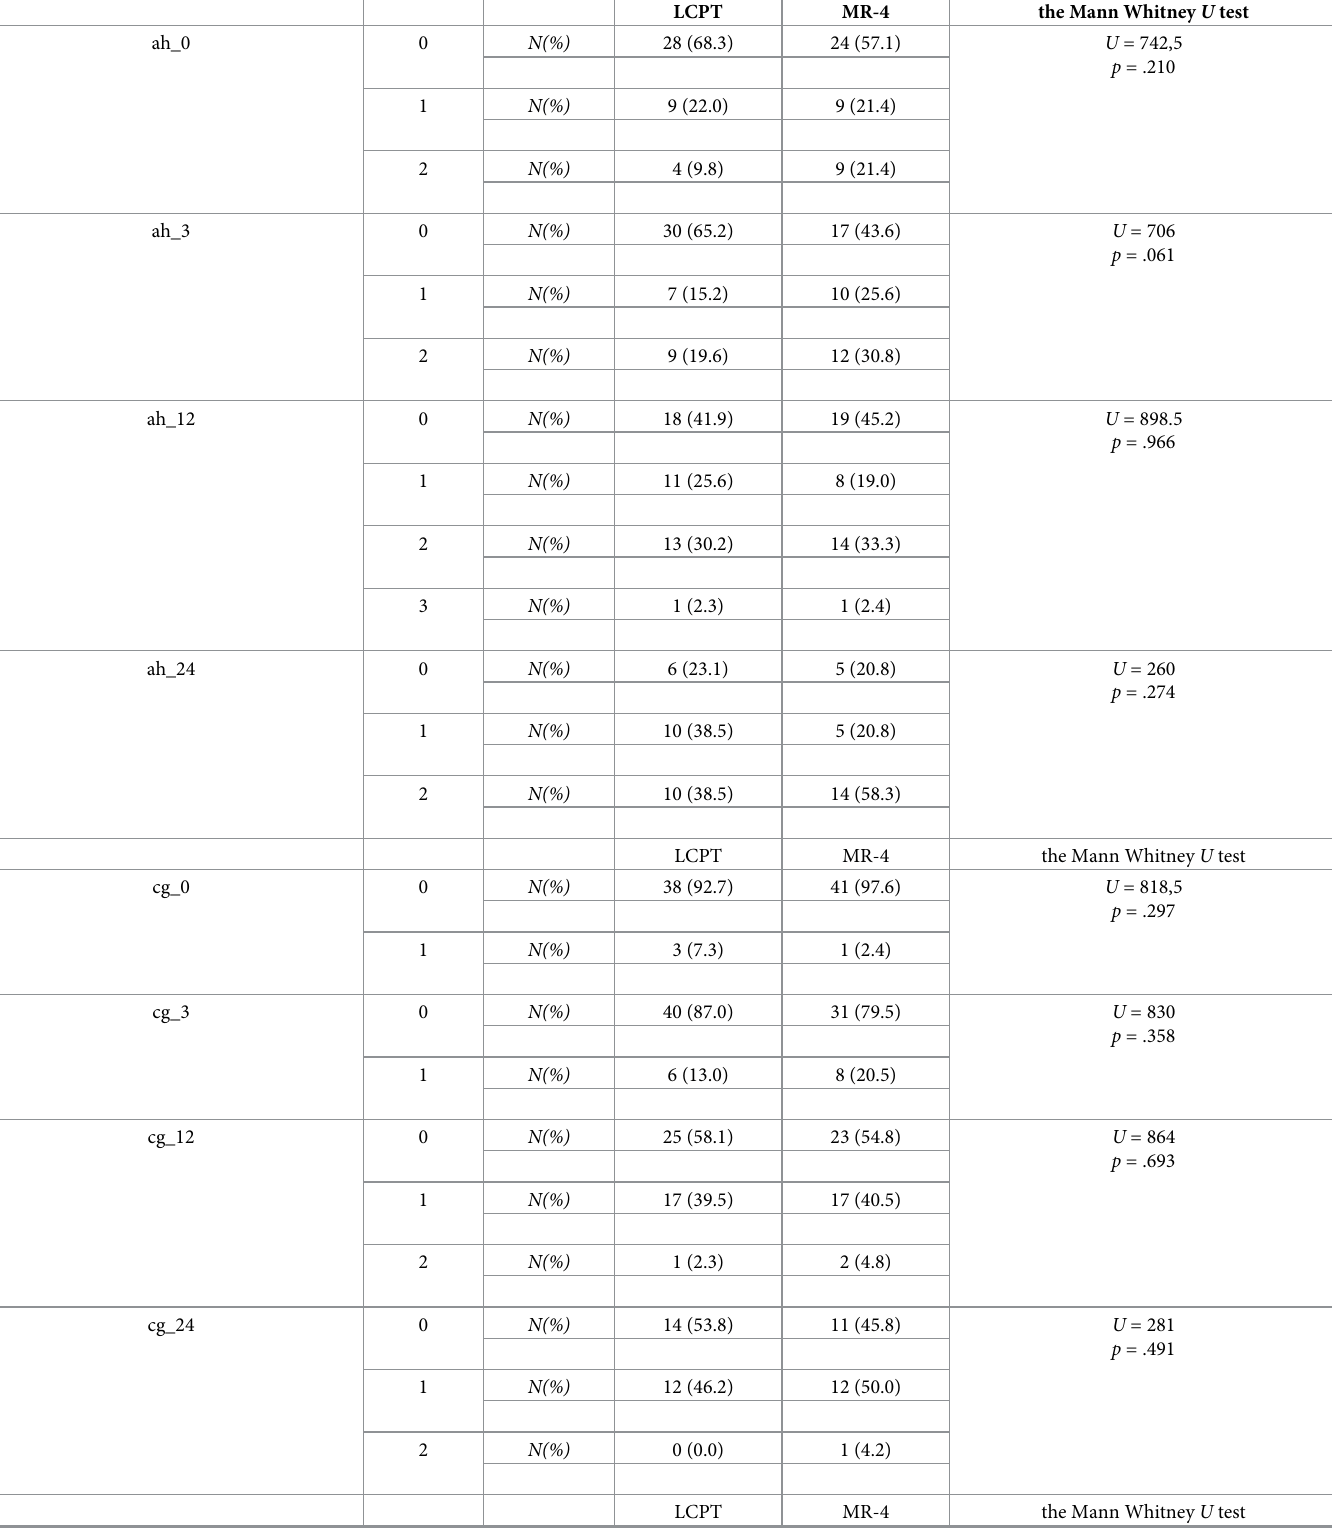
Table 3. Histological data at baseline, 3, 12 and 24 months after transplantation. Biopsy reports were available for 83 patients on implantation (41 –LCMPT, 42 –MR- 4), 85 patients at 3 and 12 months (46 –LCPT, 39 –MR-4 and 42 –LCPT, 42 –MR-4, respectively), and 50 patients at 24 months after kidney transplantation (26-LCPT, 24